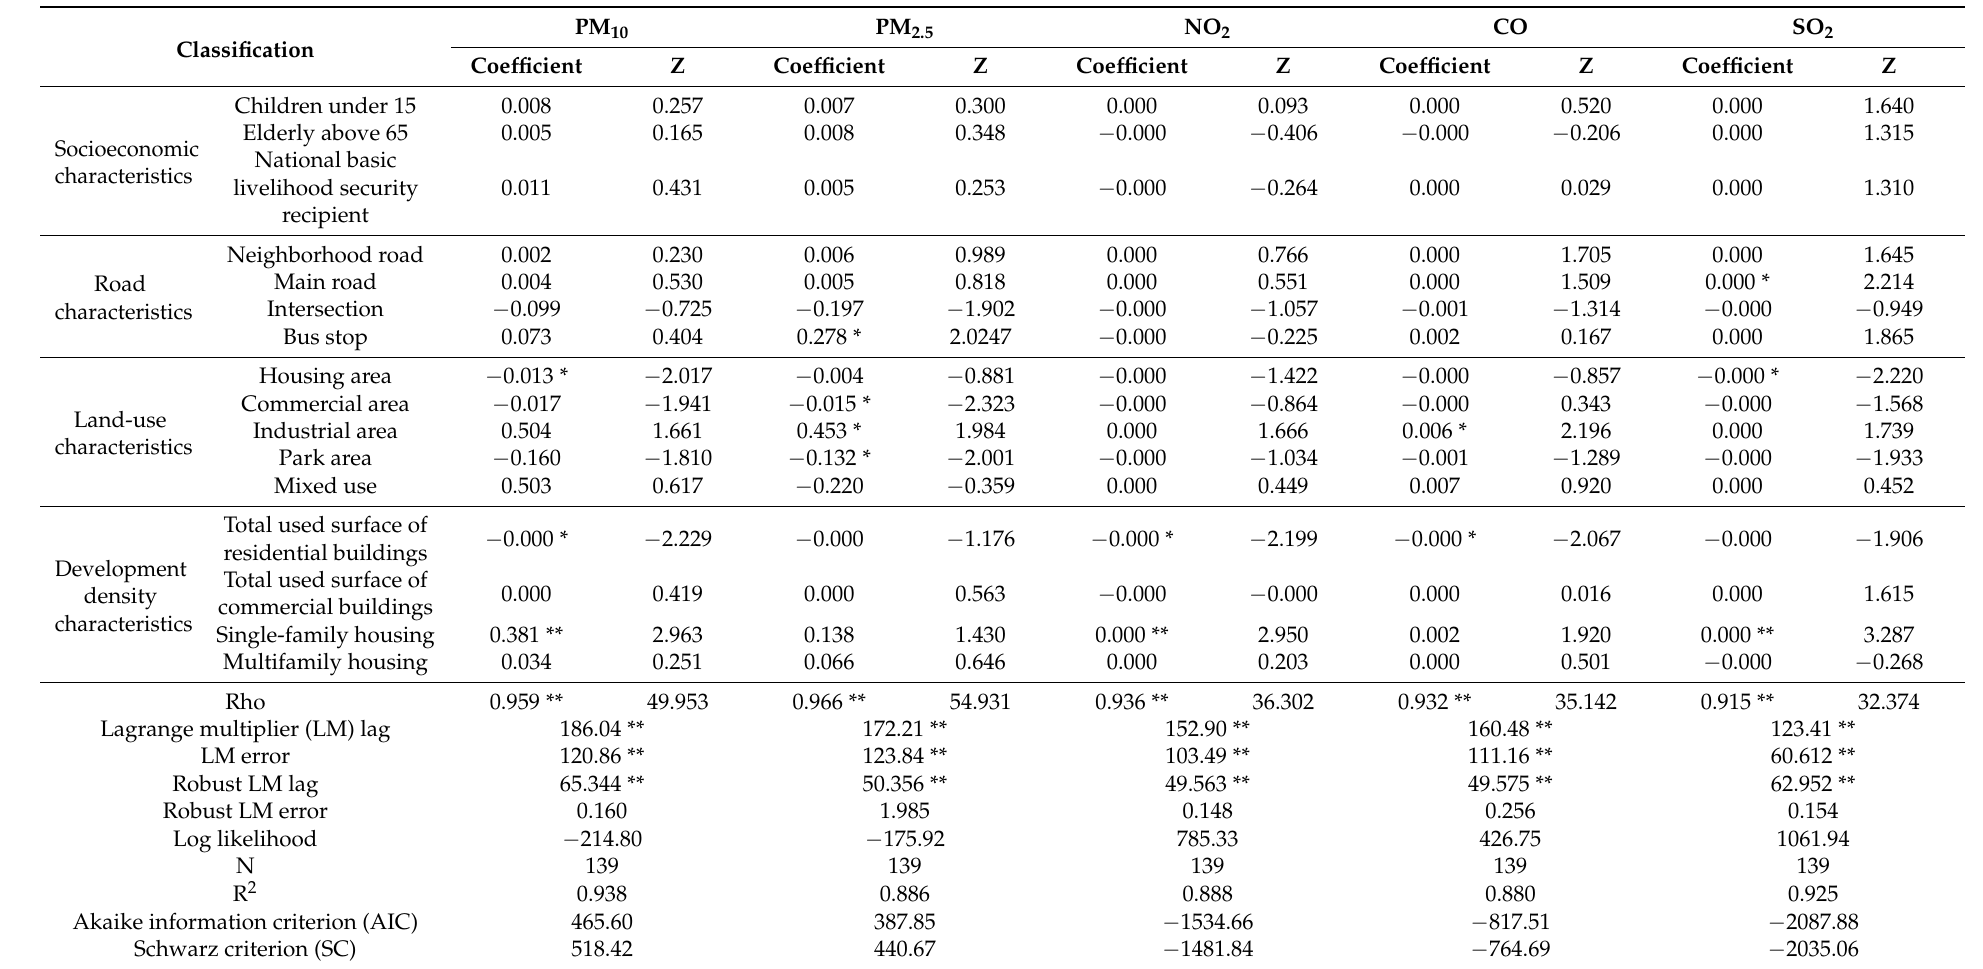
Table 4. Summary of the spatial lag models of the air